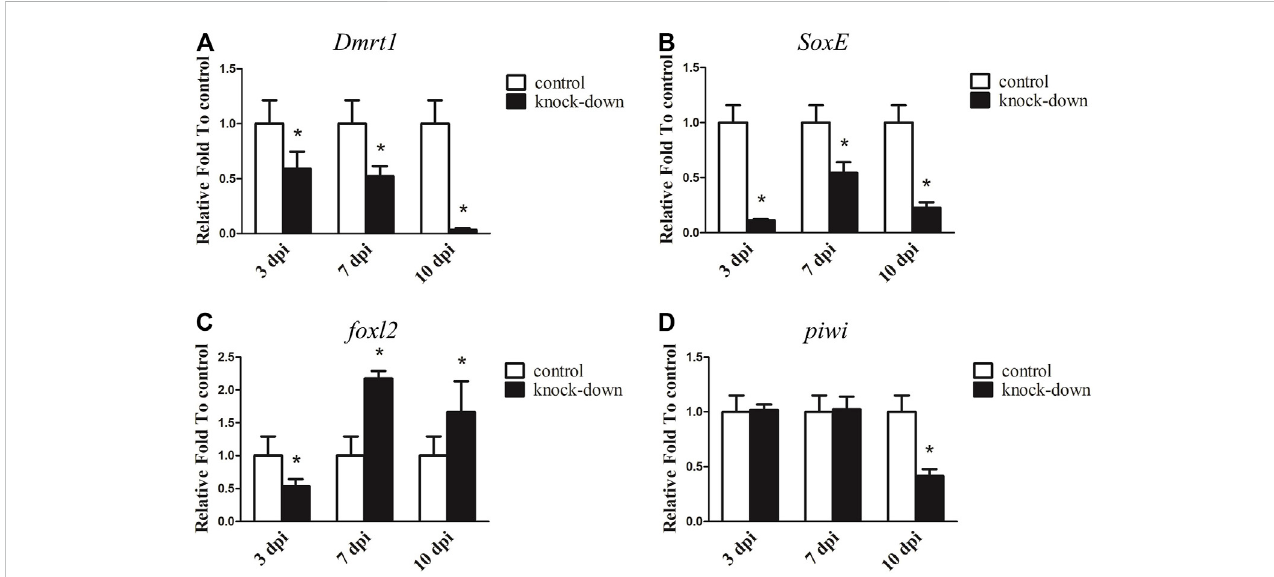
FIGURE 4 RNAinterference(RNAi)of Dmrt1 intestis.RT-qPCRdetectedmRNAlevelsof Dmrt1 andothersexrelatedgenesafter Dmrt1 RNAi. (A) Dmrt1. (B) SoxE . (C) foxl2. (D) piwi .NADHwasusedasinternalcontrol.Datawereperformedfromthreeindependentexperiments.Eachbarrepresentsmean±standarddeviation (SD). Asterisks (*) indicate signi fi cant differences ( p ≤ 0.05) between knock-down and control. dpi: days post-injection.